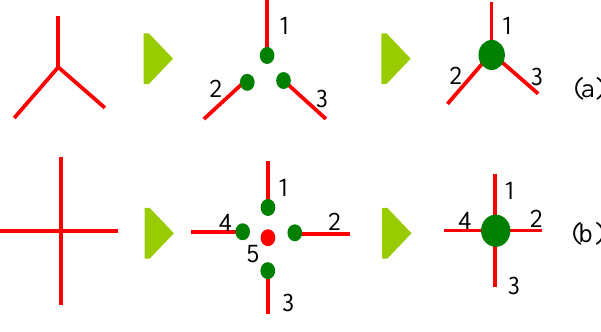
Figure 6. Merging of vertices; a) Three boundary segments pass in the same vertex; b) Five boundary segments pass in the same vertex - Case of junction relationship consists of one boundary only